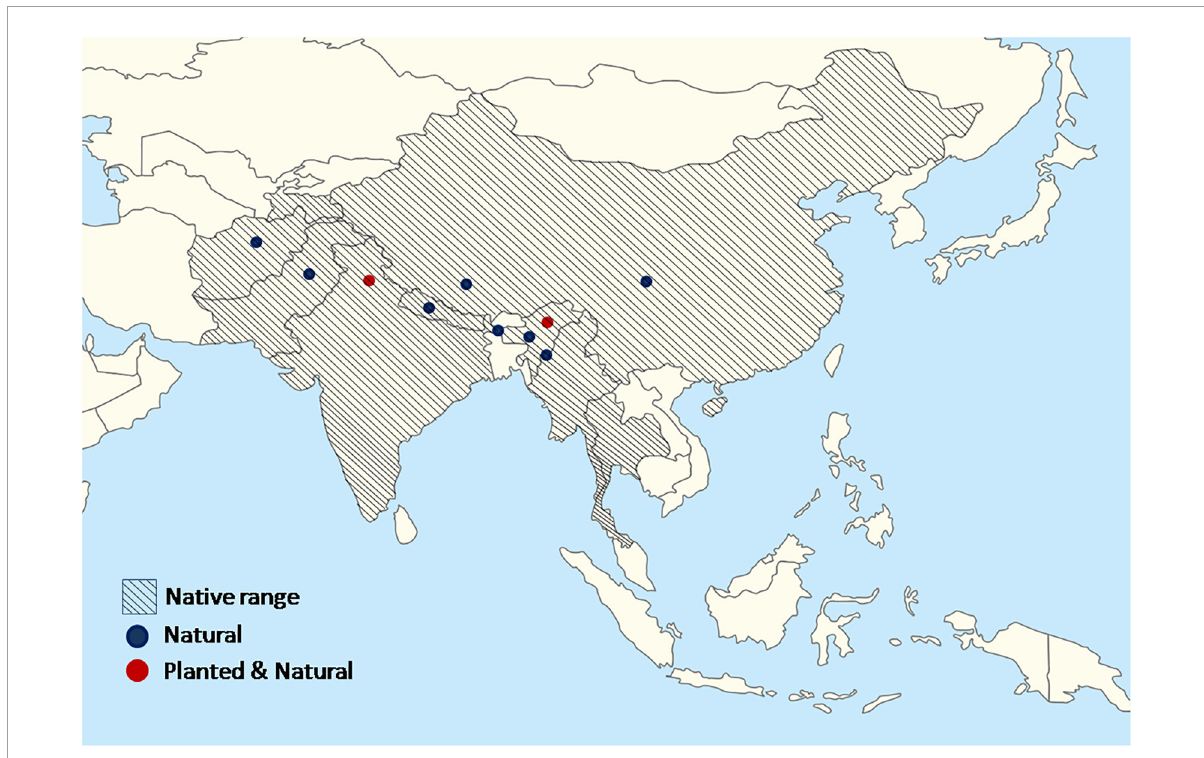
FIGURE1 A map showing the countries where the species occurs naturally and has been planted. The native range does neither suggest that the species can be available in every ecological zone within that country nor that the species cannot be planted in other countries than those depicted.